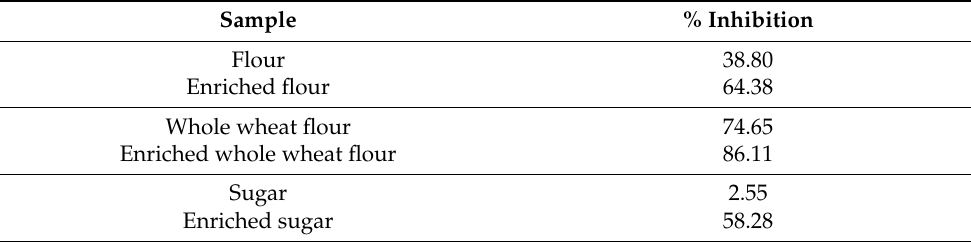
Table 2. Percent of inhibition of enriched foodstuffs compared to original